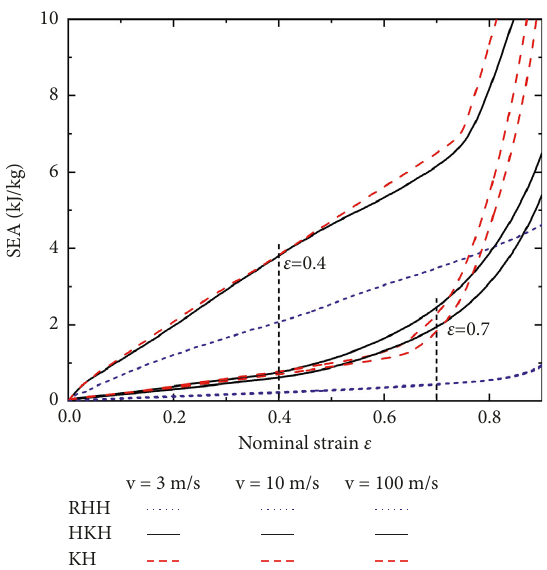
Figure 12: Specific energy absorption (SEA) curves of three honeycombs with different impact velocities.